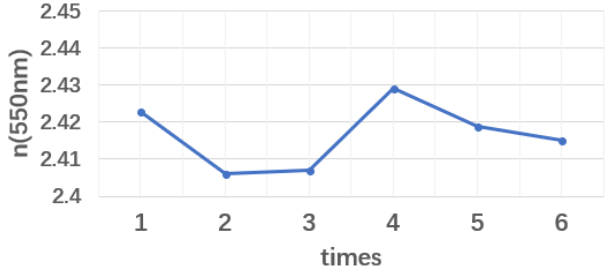
Figure 8. Run-to-run repeatability (6 repeat runs) deposited with plasma source optimum running conditions AC = 35 A, AV = 145 V, demonstrating a high degree of repeatability, the average refractive index is 2.416 ± 0.008 (spread quoted as a standard deviation).